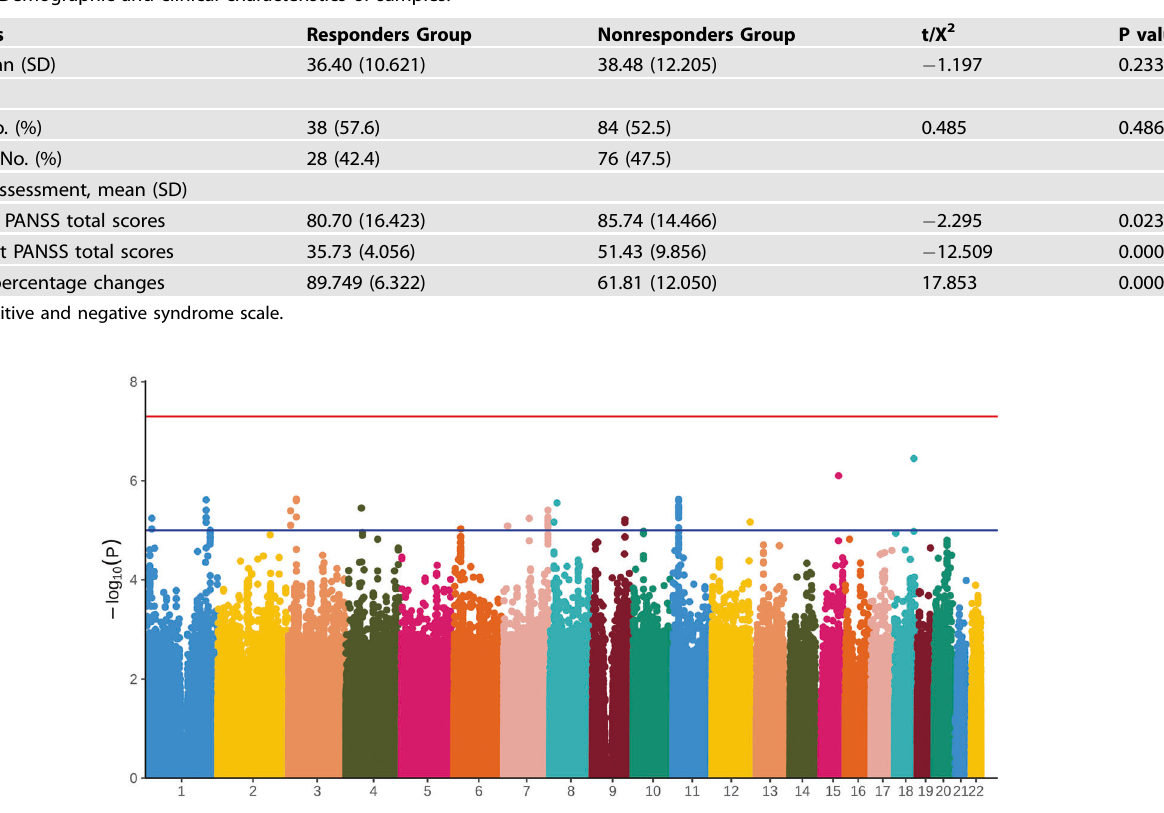
Fig. 1 Manhattan plots of P values against their respective chromosomal positions for the genome-wide association study. The bule line corresponds to the P < 1 × 10 − 5 , while the red line represents the genome-wide signi fi cance level ( P < 5 × 10 − 8